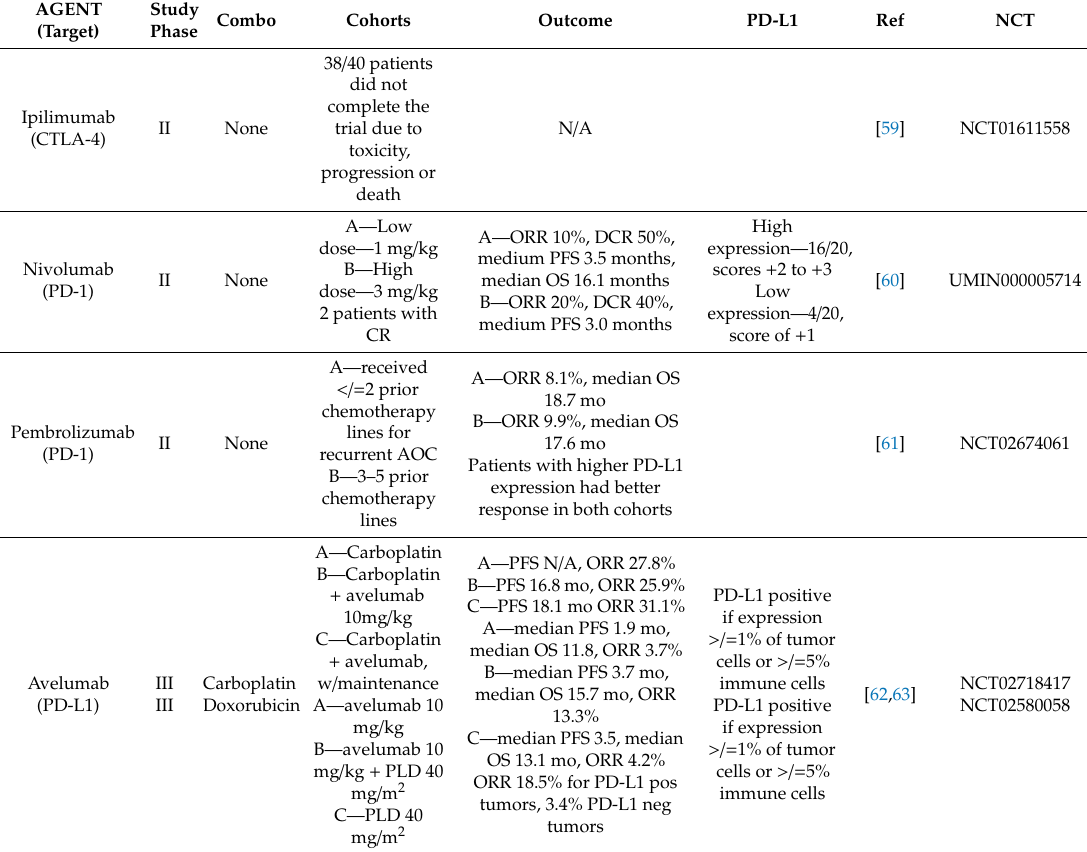
Table 2. Summary of results from trials testing immune checkpoint blockade in